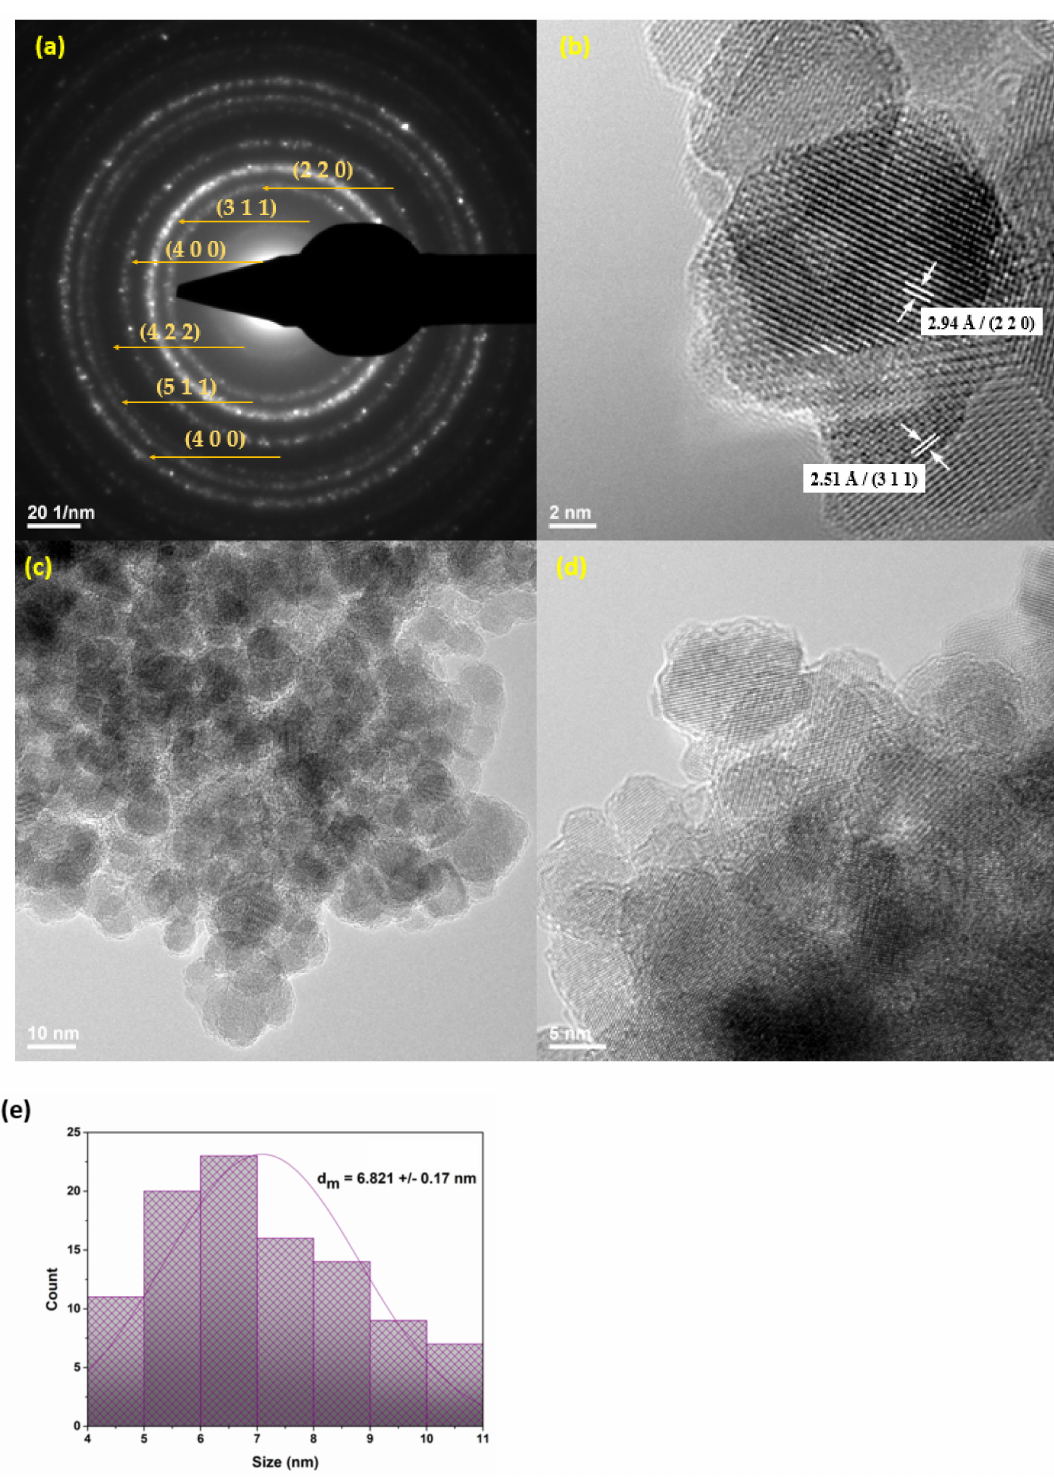
Figure 2. SAED pattern ( a ), HR-TEM image ( b ), and TEM images ( c , d ) of Fe 3 O 4 @PEG/PM; ( e ) size